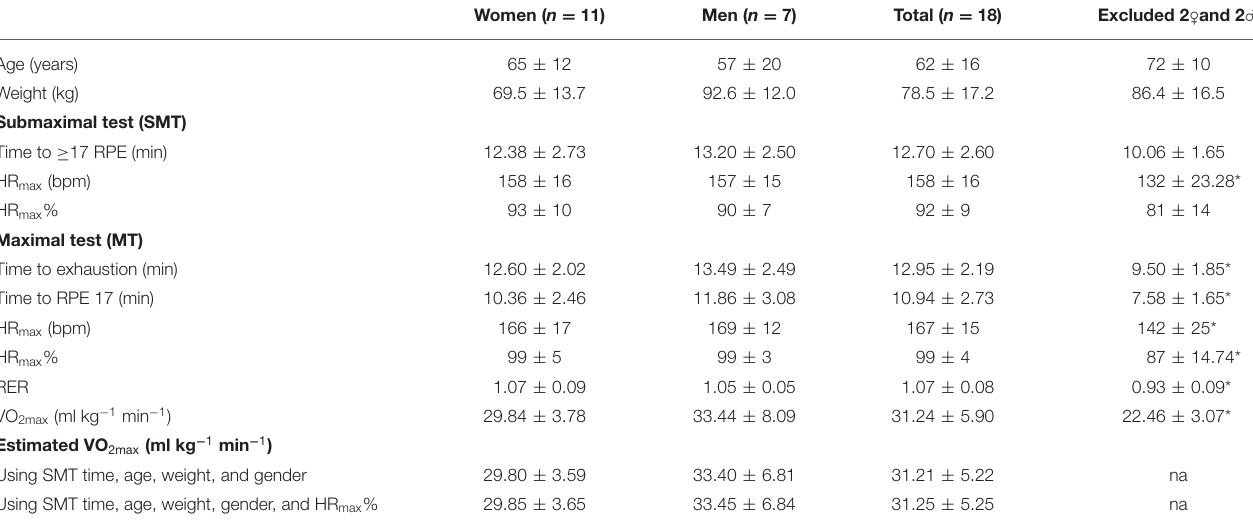
TABLE 1 | Descriptive data, results from cardiorespiratory fitness tests, and estimated VO 2max in individuals at high risk of getting or with established chronic